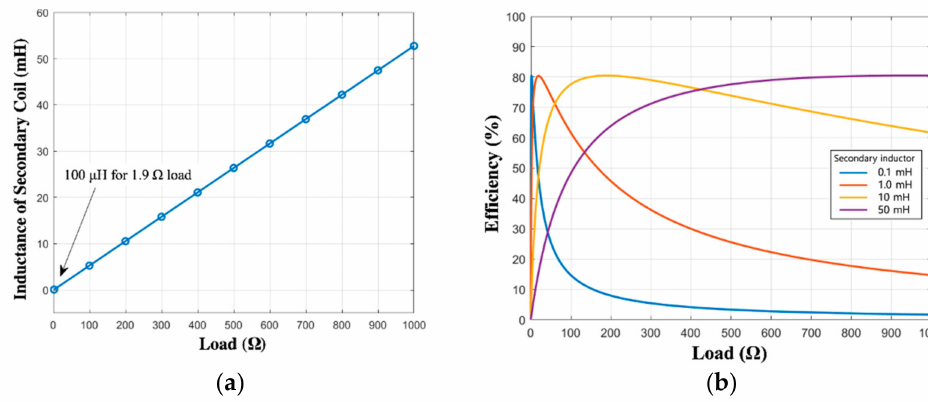
Figure 3. WPT characteristics respect to load resistance. ( a ) The required inductance of the secondary resonator for maximum efficiency. ( b ) Power transfer efficiency is displayed for different secondary inductance